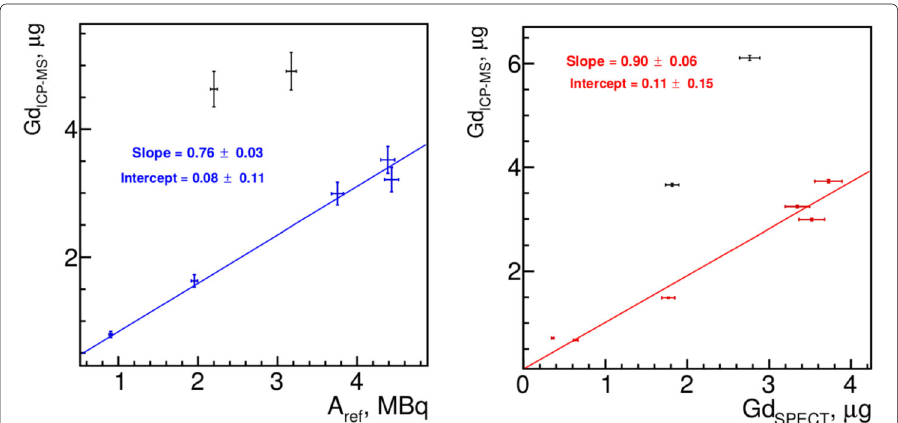
Fig. 8 Calibration and result for gadolinium mass measurement from SPECT images for in vivo studies (kidneys) Left: The α InGd ( t 0 ) coefficient at injection preparation time for in vivo studies based on left kidneys. Right: Gadolinium mass measurement from SPECT images for in vivo studies vs. expected mass of gadolinium measured with ICP-MS in right kidneys. The errors on slope and intercept are only fit errors without taking into account the systematic uncertainties from SPECT image calibration, A ref and Gd ICP − MS measurements